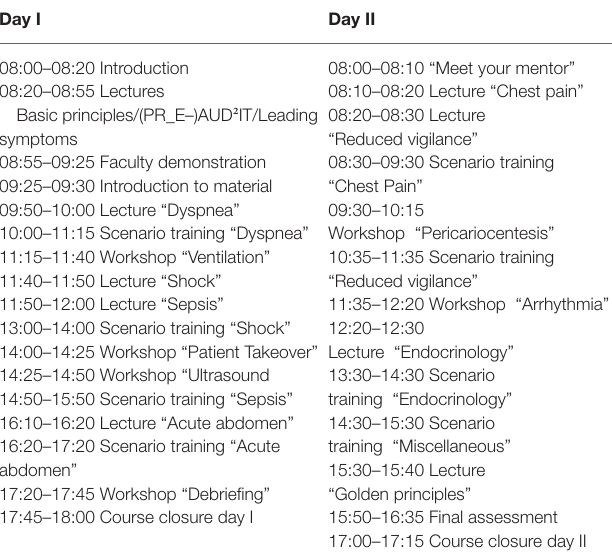
TABLE 5 | Course schedule “Advanced Critical illness Life Support” course. Day I Day II